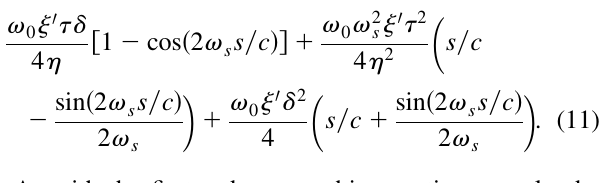
2. (Color) Plot of Z (cid:3) n; (cid:1) (cid:4) simulated versus n turns with (cid:1) (cid:5) 0 (bunch center). Shown is the analytical model of transverse beam slice motion after 1 mm kick. With fixed rms bunch length (cid:5) 3 ns and decreasing chromaticity, we can see the depth of (cid:8) (cid:1) the decoherence envelope